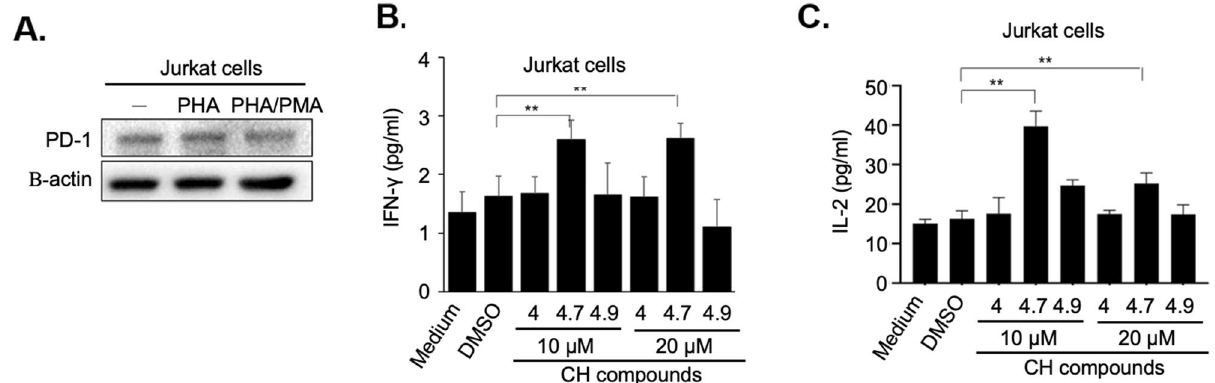
Figure 4. CH-4.7 shows sustained in vitro inhibition of PD-L1/PD-1 and T cell activation. ( A ) Jurkat cells were treated with PHA alone or in combination with PMA for 48 h and PD-1 protein (20 µg/well) expression was determined by Western blotting. Production of IL-2 ( B ) and IFN-γ ( C ) was tested by ELISA. Jurkat cells were incubated with sPD-L1 alone or in combination with CH-4, 4.7 and 4.9 (10 and 20 μM) for 48 h, then analyzed for IL-2 or IFN-γ content. CH-4.9 served as the negative control. The bar graphs present the mean ± SD (standard deviation) values from three independent experiments. ** p < 0.01, *** p < 0.001.